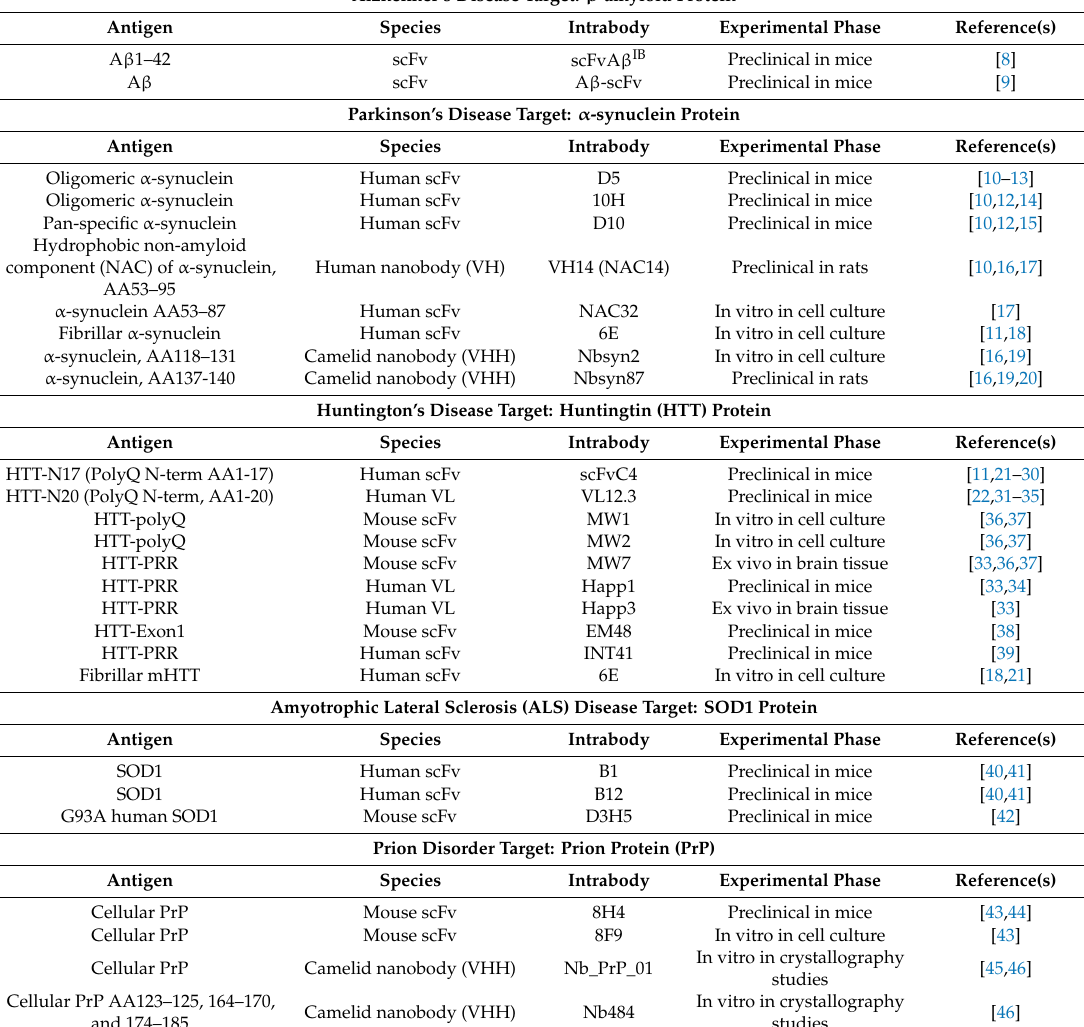
Table 1. Intrabodies against neurodegenerative